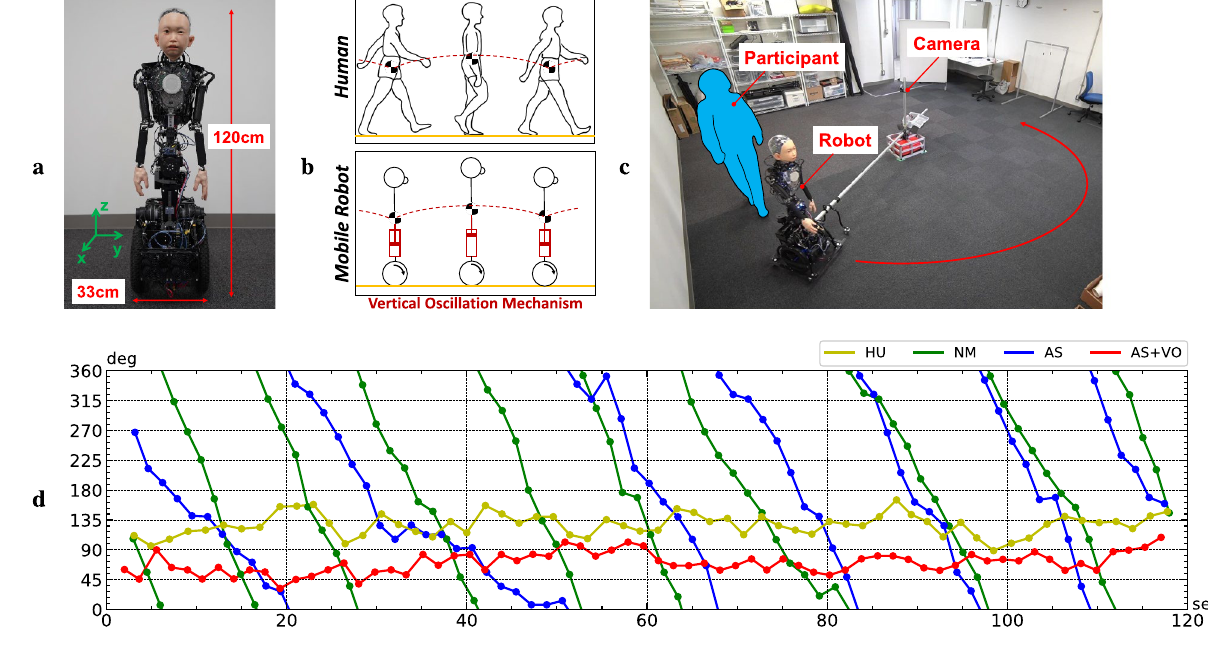
Figure 1. Overview of the experiment: ( a ) ibuki : a child mobile android robot with a human-like appearance. ( b ) a vertical-oscillation mechanism (VOM) of ibuki ’s mobility unit which actuates its upper body vertically while moving, similar to the way the human upper body oscillates while walking. ( c ) The experimental setup: every participant walked behind a human (HU)/the robot with three types of upper body motion patterns (NM, AS, and AS+VO) ( d ) One of the representative obtained time-series phase difference graphs under four condition (Participant 3 in Fig. 3). The horizontal axis shows the measurement time (s) and the vertical axis shows the phase difference (deg). Yellow: HU, green: NM, blue: AS, and red: AS+VO